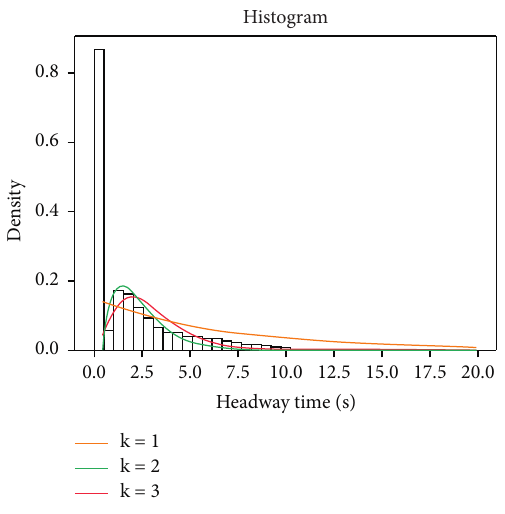
Figure 7: Headway distribution.